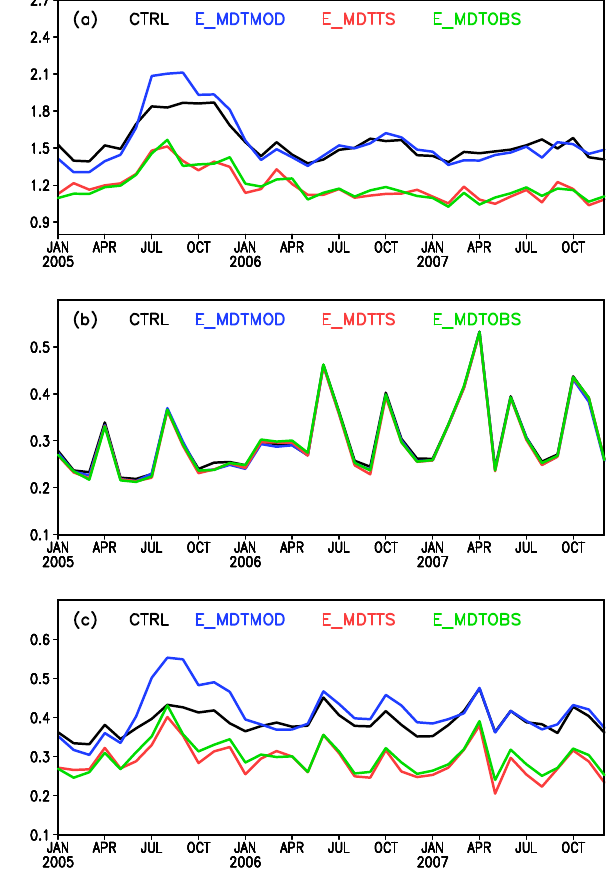
Figure 3. Time series of temperature ( a ; unit: ◦ C) salinity ( b ; unit: psu), and density ( c ; unit: kgm − 3 ) averaged over the southwest- ern area including the Agulhas current system and the upper 300m from different experiments. Black: CTRL; blue: E_MDTMOD; red: E_MDTTS; green: E_MDTOBS; yellow: Argo.